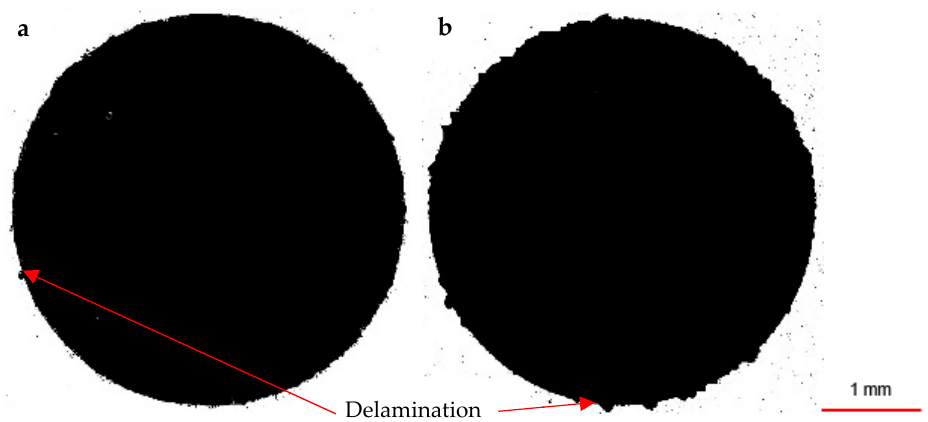
Figure 8. ( a ) Minimum and ( b ) Maximum delamination at the exit hole of the CFRP panel for all runs.